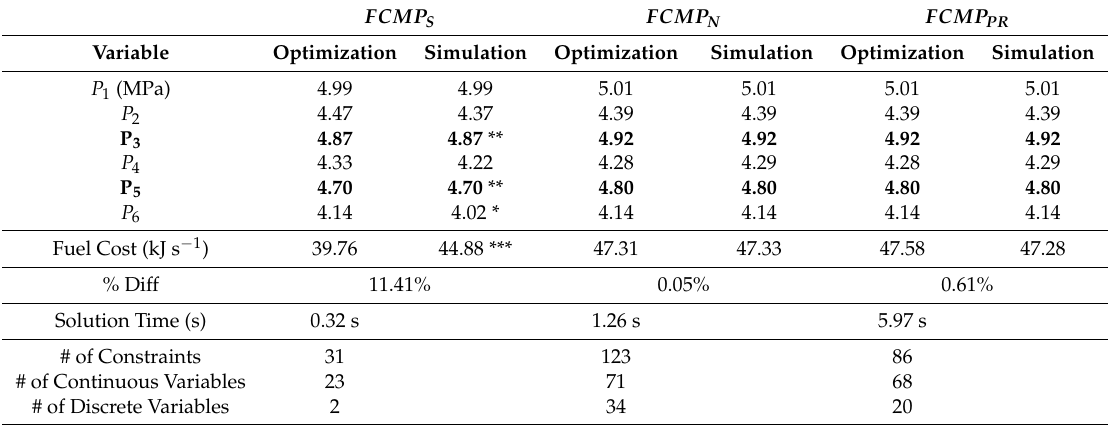
Table 3. Example 1 case study results. Both compressor stations only have one unit active in all three model solutions. Lines in bold represent outlet pressures from compressor stations. FCMP S FCMP N FCMP PR Variable Optimization Simulation Optimization Simulation Optimization